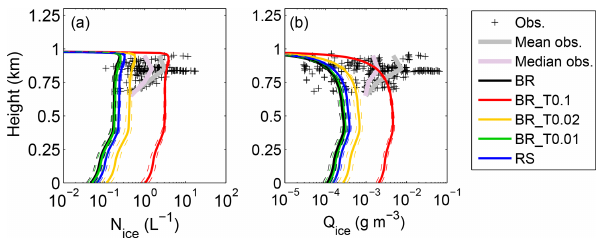
Figure 6. Same as in Fig. 5 but for the LES simulations with only one SIP mechanism active: BR (black), BR_T0.1 (red), BR_T0.02 (yellow), BR_T0.01 (green) and RS